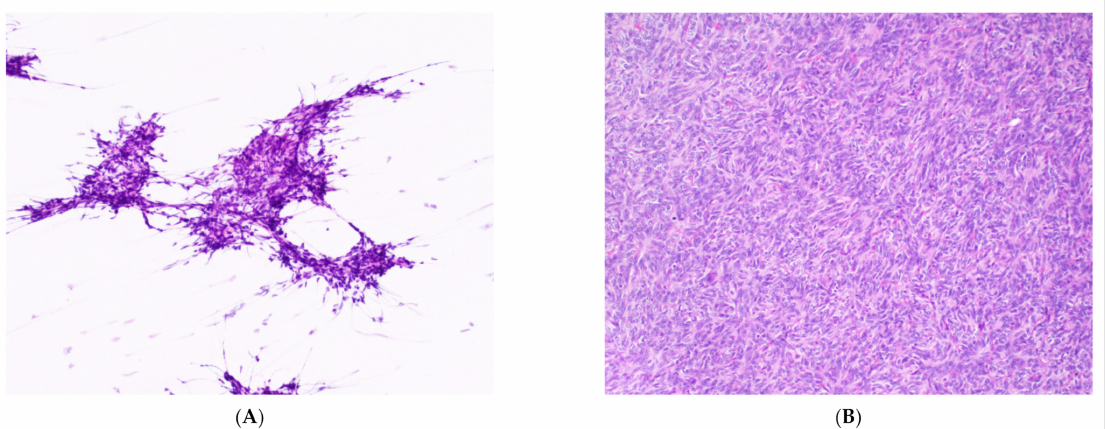
Figure 3. Type A thymoma. ( A ) Smear shows clusters of spindle-shaped epithelial cells on a background of few lymphocytes. H&E stain, 20 × objective. ( B ) Corresponding spindle cells are seen in the surgical resection of type A thymoma. H&E stain, 20 × objective.